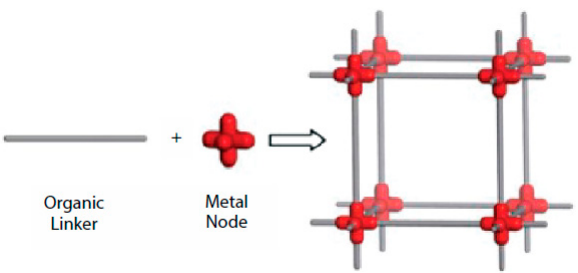
Figure 1. A schematic structure of MOFs. (Reproduced with permission from Ref. [9] with permission from Wiley Online Library, 2022).